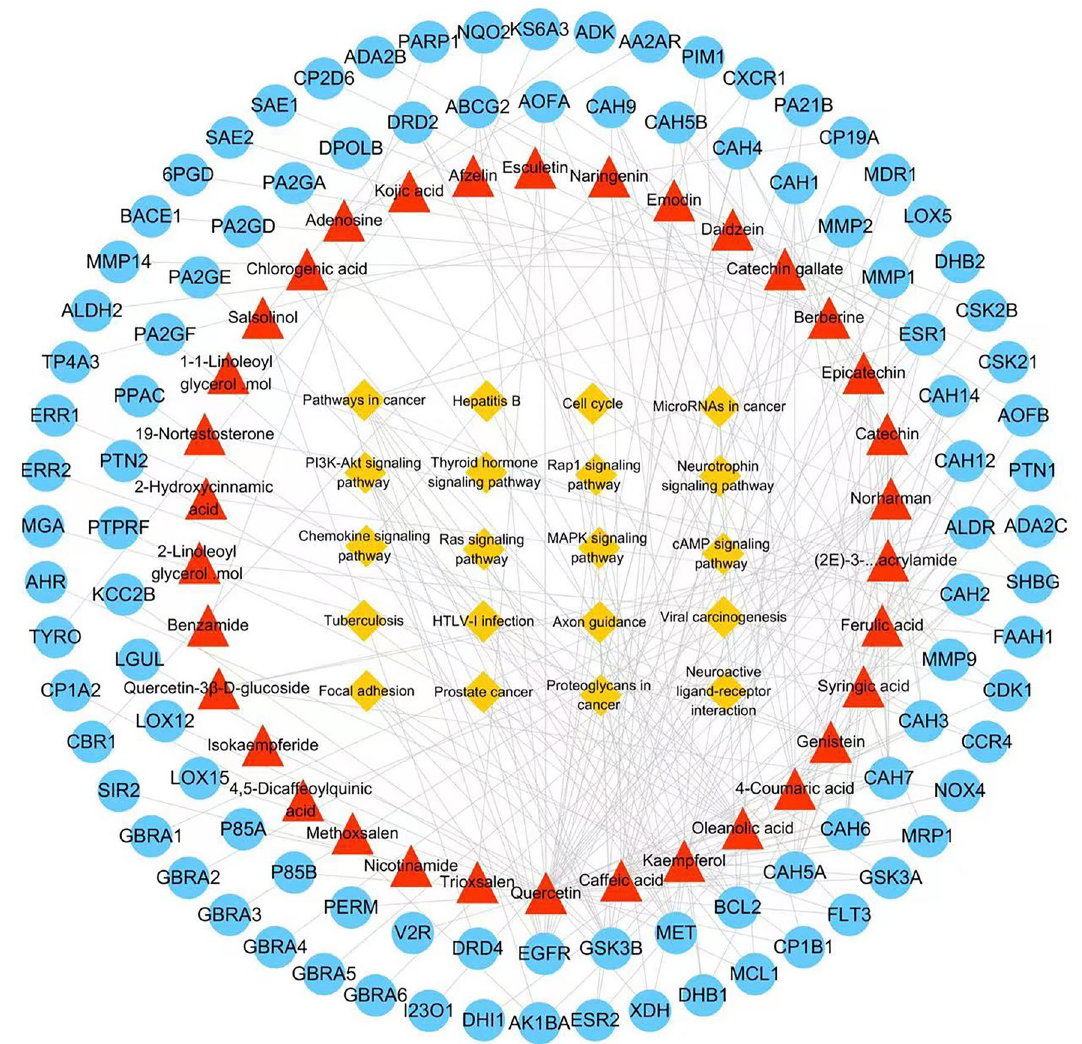
Figure 4. Compound-target-pathway network. Blue circle, red triangle, yellow square represent target, compound and pathway, respectively. Edge indicates the